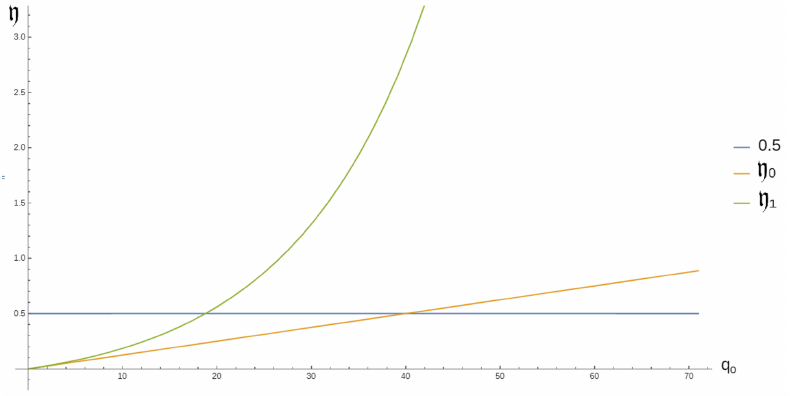
Figure 2. The iterations y r , for r = 0,1 in the special case